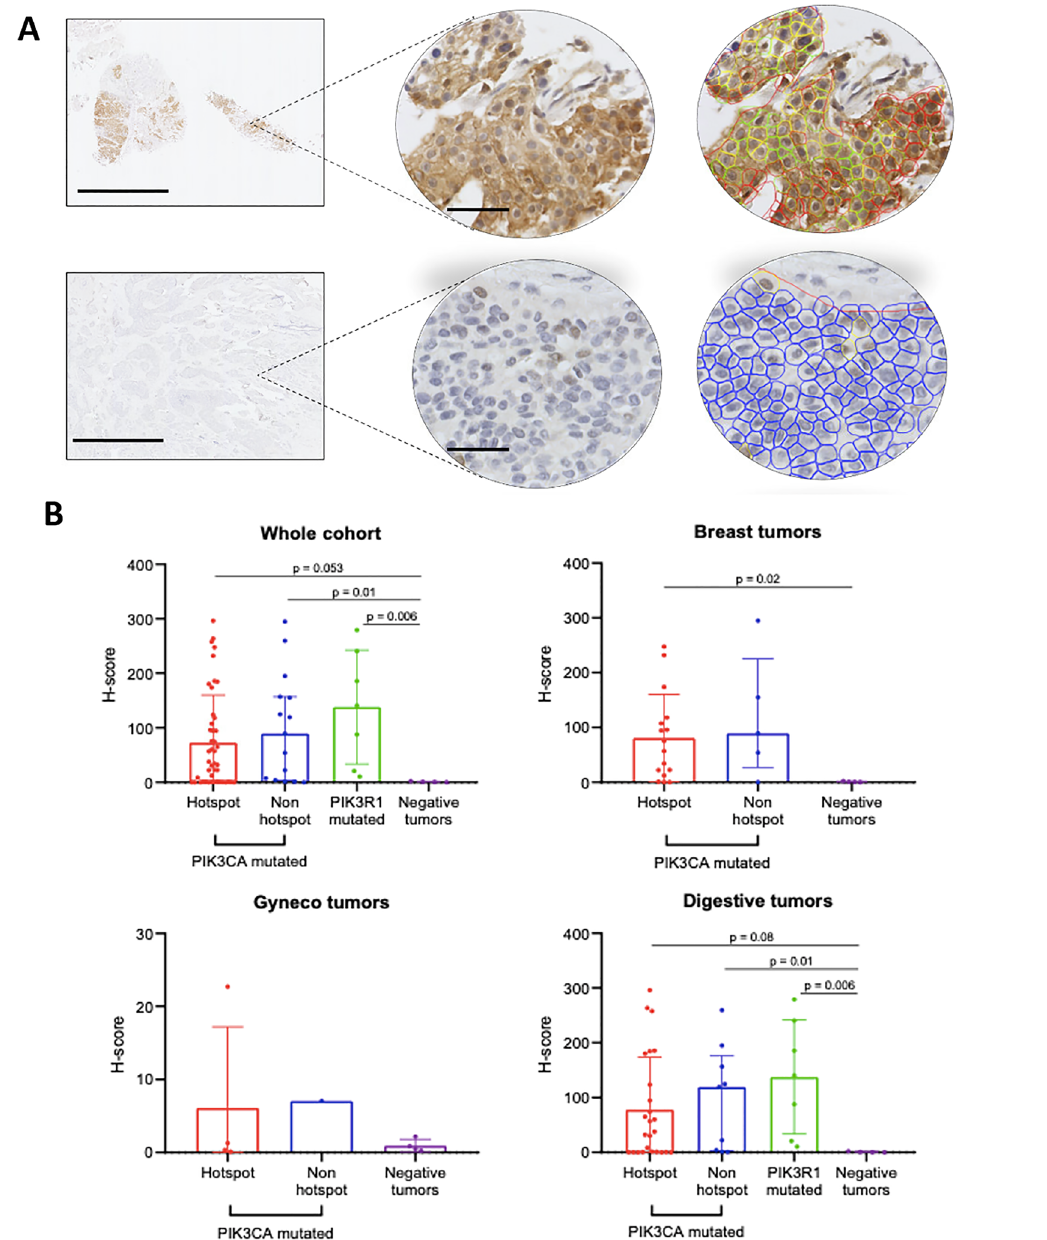
Figure 5. ( A ) Representative p-AKT positive tumor (upper panel) and negative tumor (lower panel). On the left side, low magnification of tumor (scale bar is 1.5 mm), on the middle part, high magnification (scale bar is 50 µm) and on the right side, high magnification with QuPath intensity mask (blue for negative cells, yellow for 1+ cells, green for 2+ cells and red for 3+ cells).( B ) H score according to the type of mutation ( PIK3CA hotspot, PIK3CA non hotspot, PIK3R1 , control tumors = negative